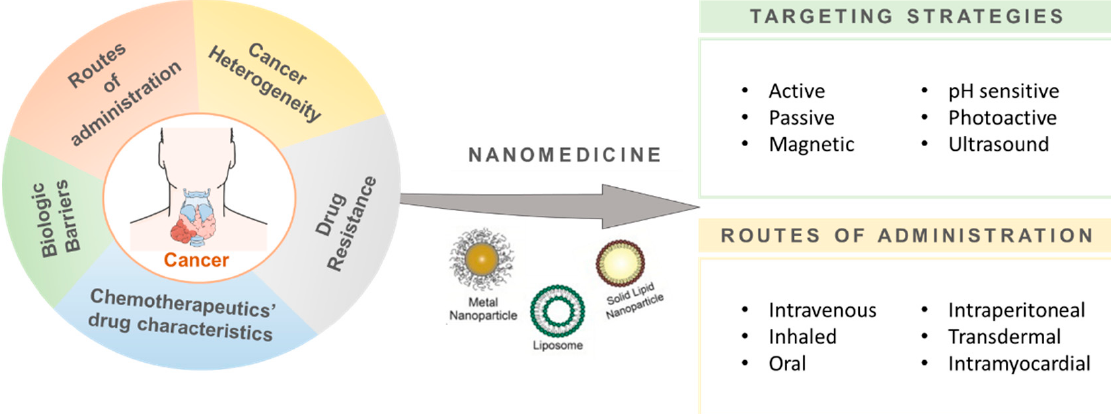
Figure 1. Nanomedicine applications in cancer therapy. Nanoparticles, as drug delivery systems, can enhance the drug targeting to specific body/organ/tissue or even single cancer cells through different targeting strategies (e.g., active/passive, endogenously/exogenously responsive) and different routes of administration (intravenous, oral, or intraperitoneal, among others).